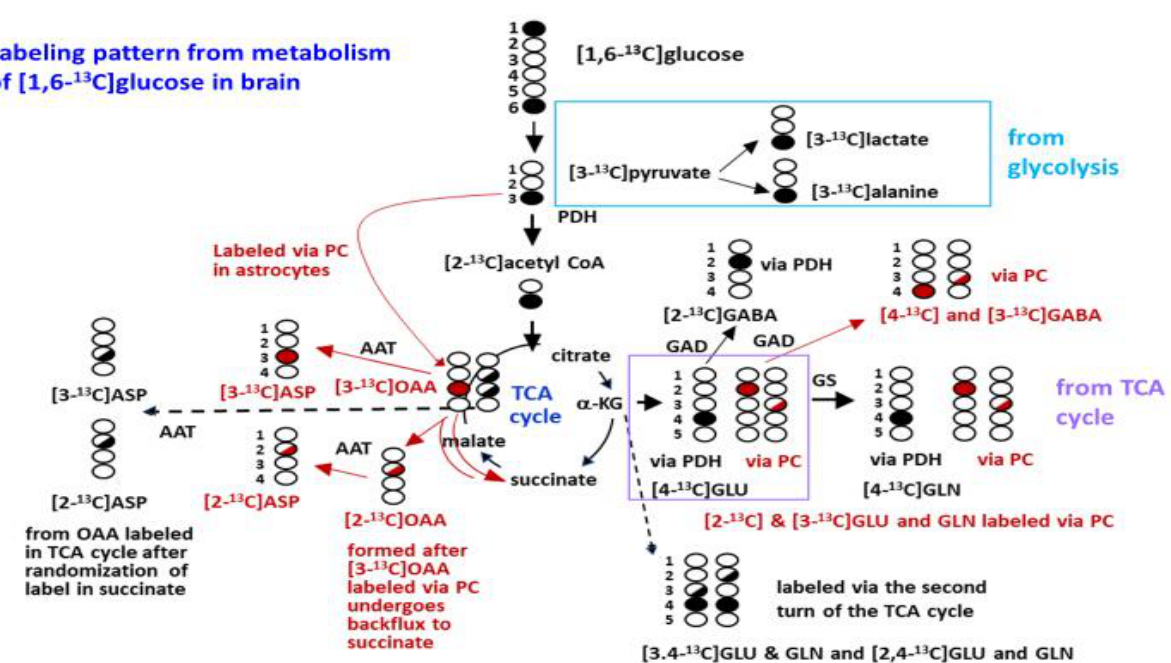
Figure 1. Labeling pattern from the metabolism of [1,6- 13 C]glucose in the brain. The labeling pattern from the metabolism of [1,6- 13 C]glucose via glycolysis, pyruvate dehydrogenase (PDH) and metabolism in the first turn of the TCA cycle and subsequent formation of glutamate is shown in black circles. Formation of glutamate C4 (GLU C4) from metabolism in the first turn of the TCA cycle, which is stronger in neurons but also occurs in astrocytes, and subsequent conversion to glutamine C4 (GLN C4) in astrocytes is indicated by black circles. Further metabolism of α -ketoglutarate C4 ( α -KG) in the TCA cycle results in randomization of the label in the symmetrical molecule succinate and leads to formation of malate and oxaloacetate (OAA) equally labeled in the C2 and C3 positions (half-filled black circles). OAA can remain in the TCA cycle or be transaminated to form aspartate (ASP C2 and C3). Labeling of OAA from metabolism via the pyruvate carboxylase (PC) pathway in astrocytes leading is shown in red circles. Backflux of OAA C3 labeled via PC leads to partial labeling of OAA C2 (partially filled red circle). Metabolism of OAA labeled via PC leads to labeling of GLU and GLN in the C2 indicated by red circles. Some labeling in the C3 positions of GLU and GLN occurs from the backflux labeling in OAA. GABA C2 is formed from glutamate labeled via PDH in the first turn of the TCA cycle (black circles) and GABA C4 and some GABA C3 is labeled from precursors formed via PC (red circles). For simplicity, labeling from the first turn of the TCA cycle is shown and labeling of GLU and GLN from the second turn is shown. It should be noted that GLU C3 and C2 are also labeled in the second turn of the TCA cycle and GABA C3 can be formed from GLU C3 formed in neurons. Additional details of the labeling and pathways are given in the methods section. Abbreviations: AAT, aspartate aminotransferase; GABA, Υ -aminobutyric acid; GAD, glutamic acid decarboxylase; GLU, glutamate; GLN, glutamine; GS, glutamine synthetase; OAA, oxaloacetate; PDH, pyruvate dehydrogenase complex; PC, pyruvate carboxylase. (Figure reproduced with permission from Ferreira et al. [30]).